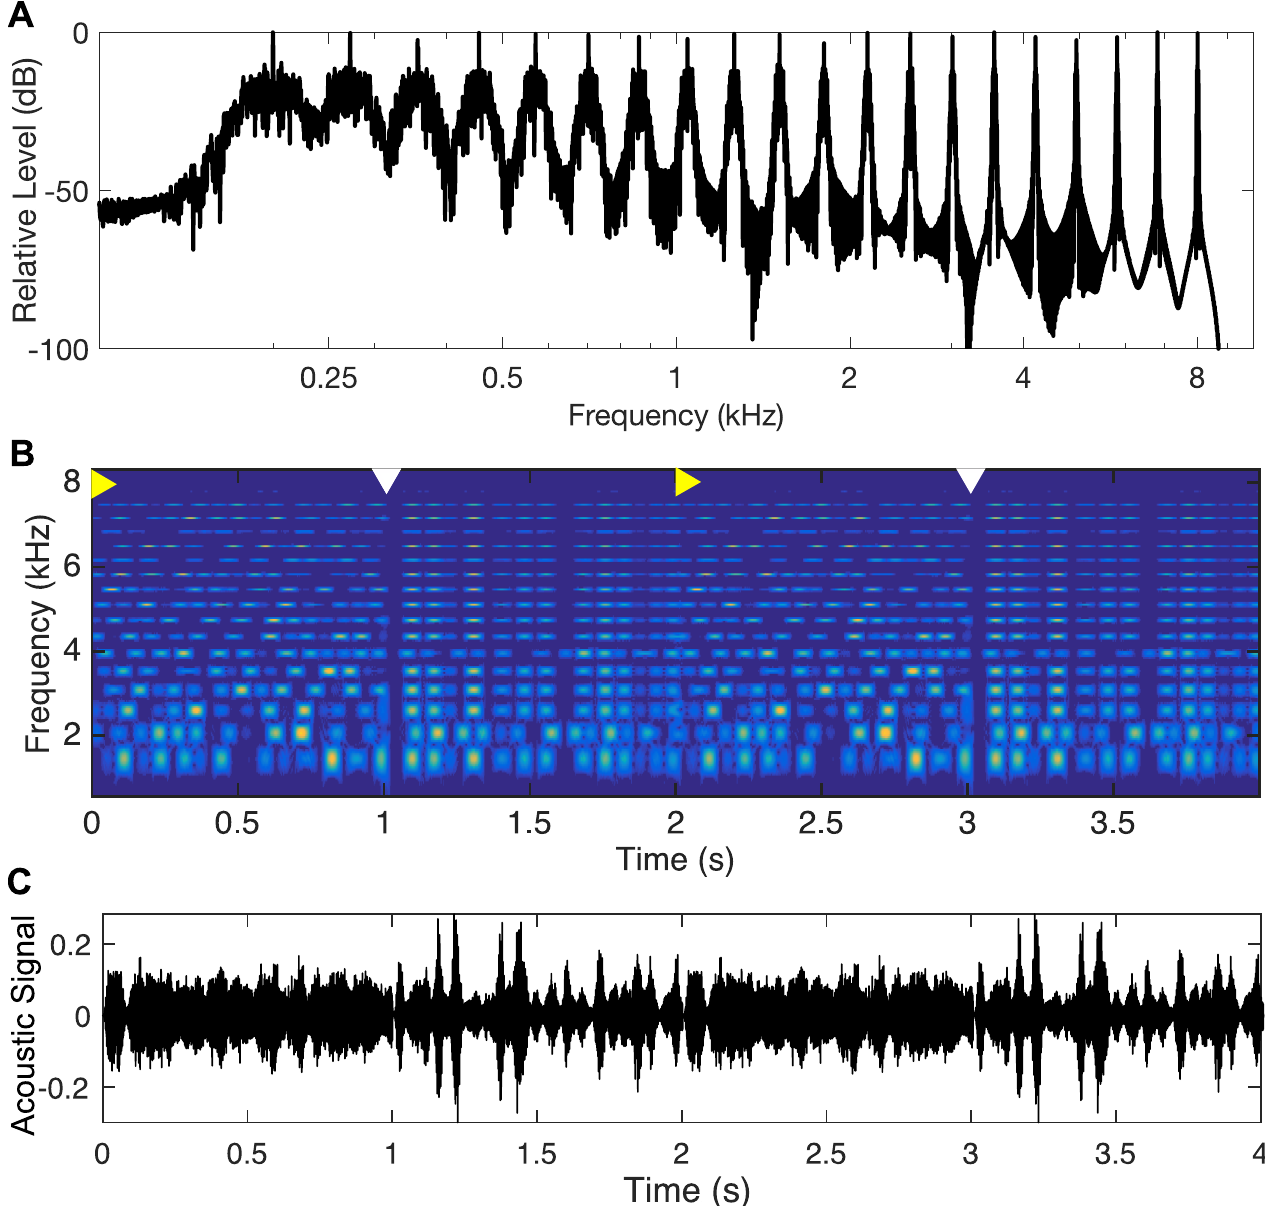
Fig 1. Stimulus properties and design. (A) Tone mixture used as carrier for the temporal coherence stimuli. (B) Depiction of one trial. Yellow right-pointing arrows on top mark onset of non-coherent modulation periods (1 s), and white down-pointing arrows on top mark onset of coherent modulations of N = 6, 12, or 18 out of 20 tones, randomized. There were two 1-s-long coherent periods per trial. (C) Sample acoustic waveform from one